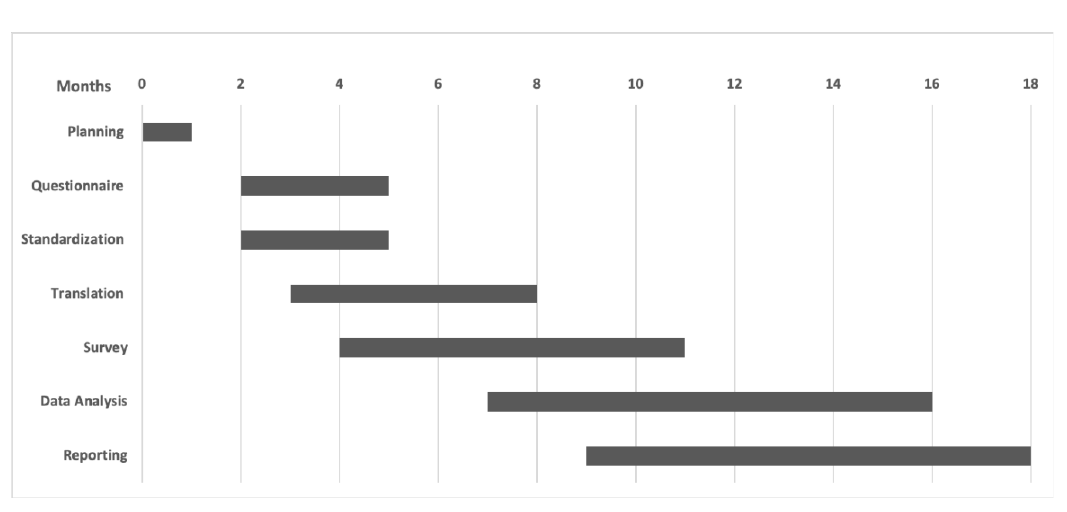
Figure 1. Gantt Chart of the survey.